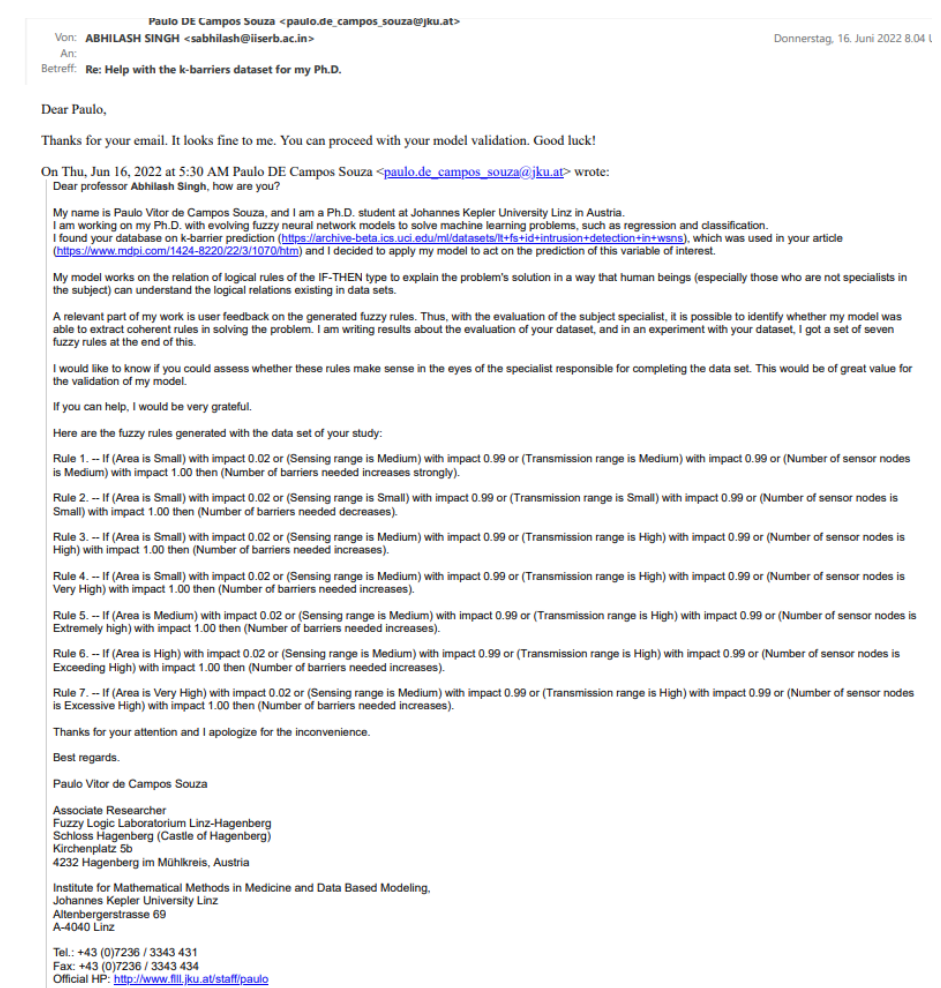
Figure A1. Confirmation email about the consistency of the generated fuzzy